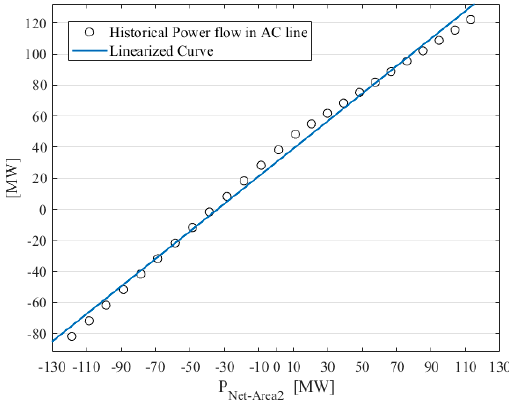
Figure 16. Response curve of P ref _ DEC = h ( P net − Area 2 ) .